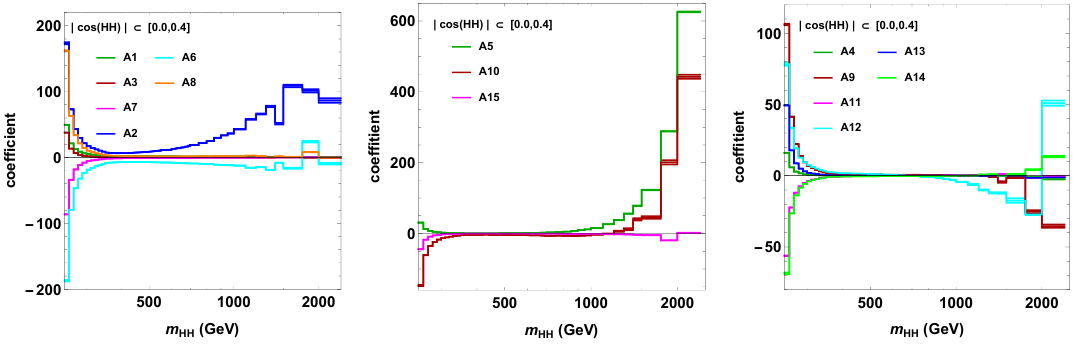
Figure 14 . Values of the fit coefficients entering R j display the results for the central cos θ ∗ bin (betweem 0 and